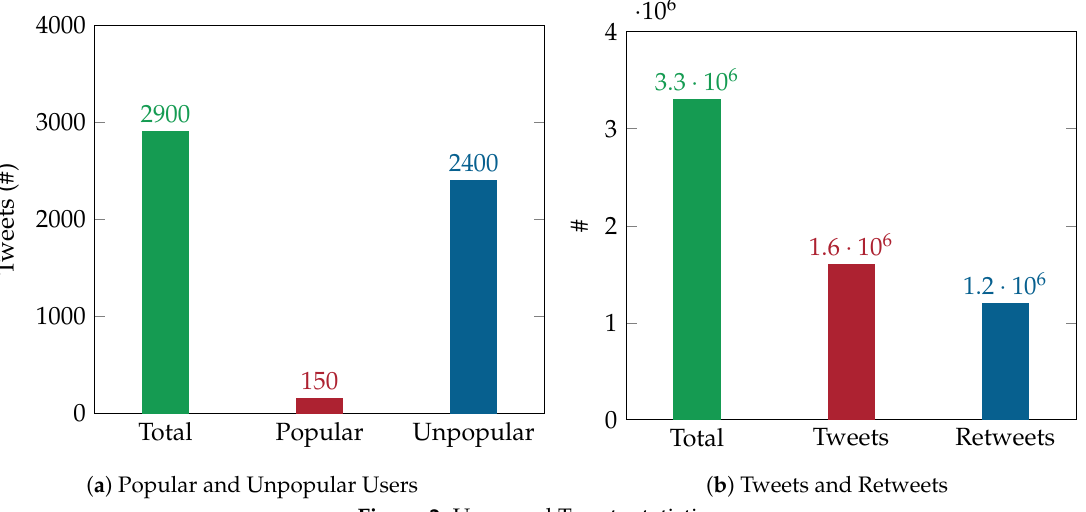
Figure 2. Users and Tweets